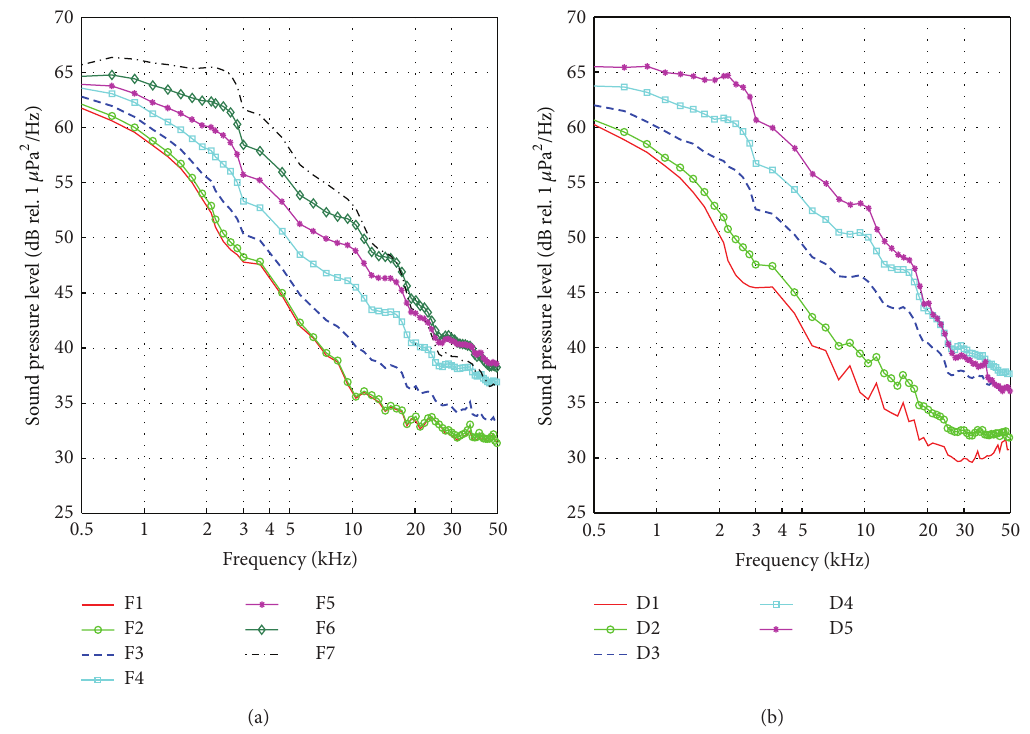
Figure 11: Sound pressure level average spectra collected by Passive Aquatic Listener divided into (a) Beaufort wind speed classes F1 to F7 as measured by the anemometer on board the buoy and (b) Douglas significant wave height classes D1 to D5 as estimated by the wave meter system of the